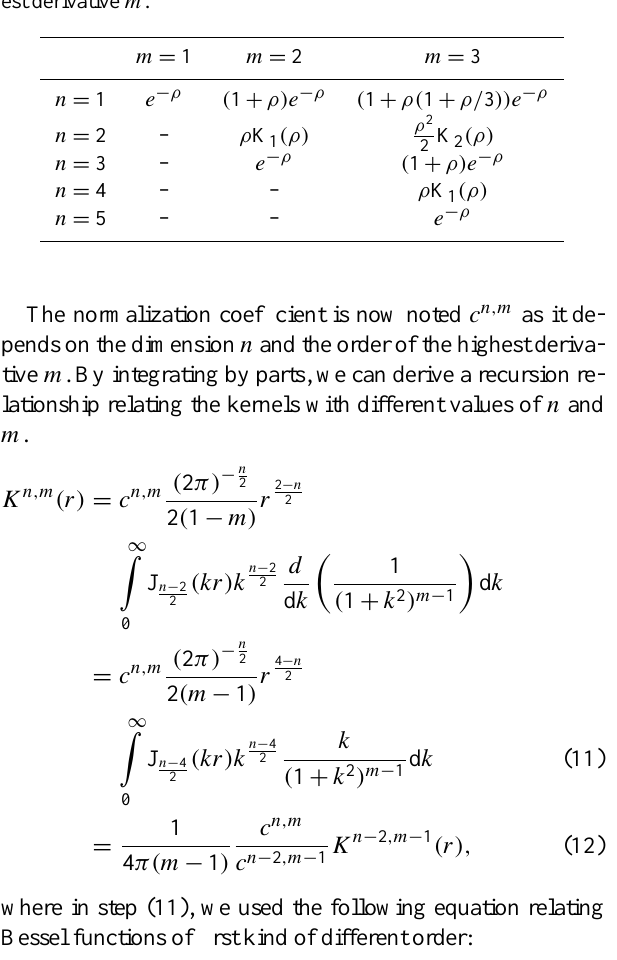
Table 2. Normalization coefficient c n,m for different values of the dimension n and the highest derivative m